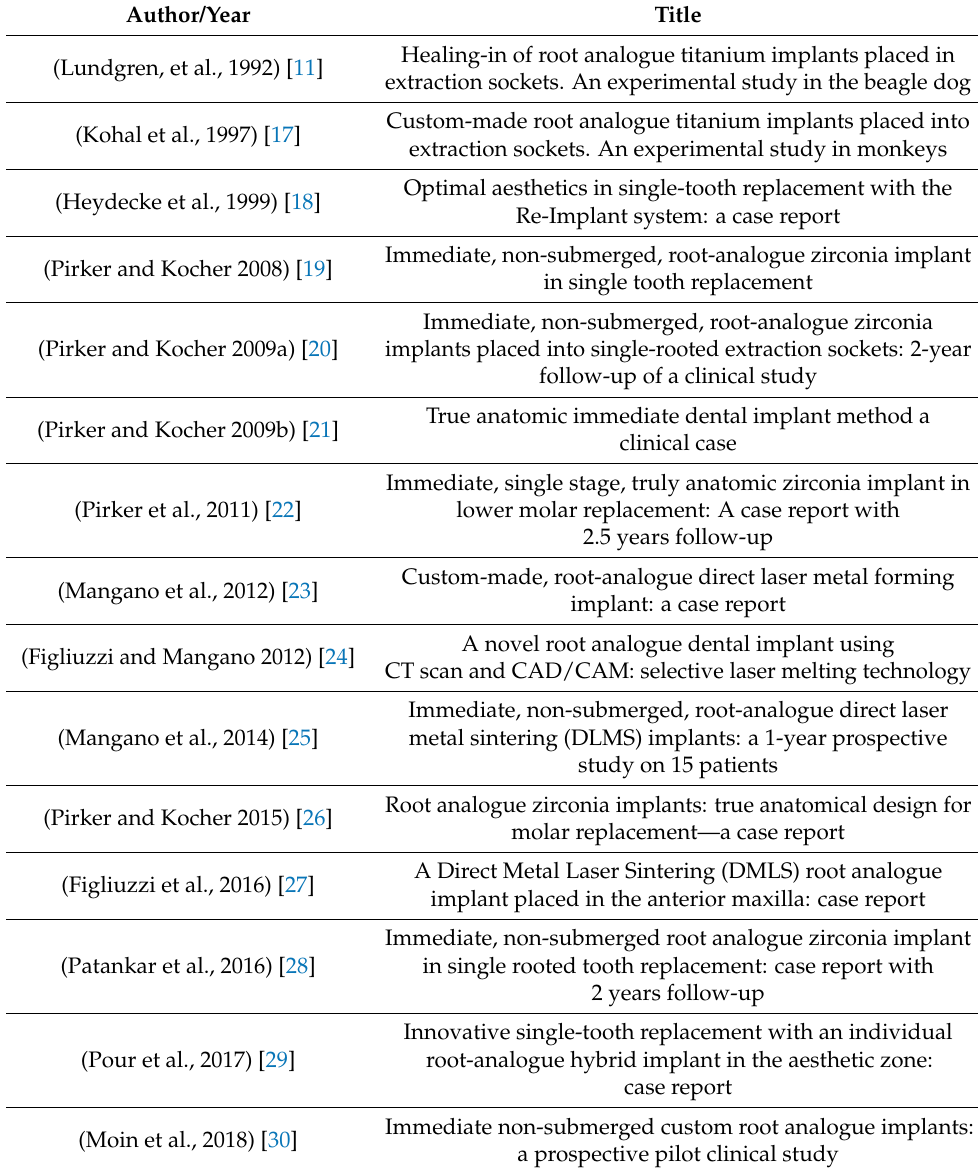
Table 1. Articles included in the